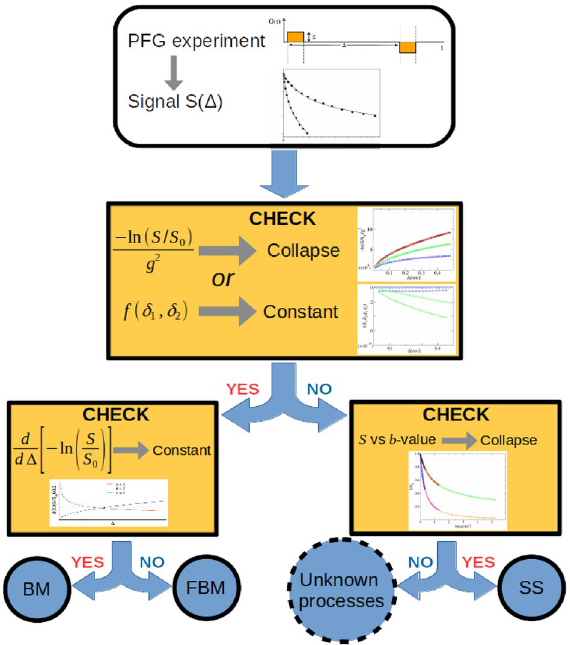
Figure 7. Flowchart of validation rules. The sequence of validation rules are summarized in this